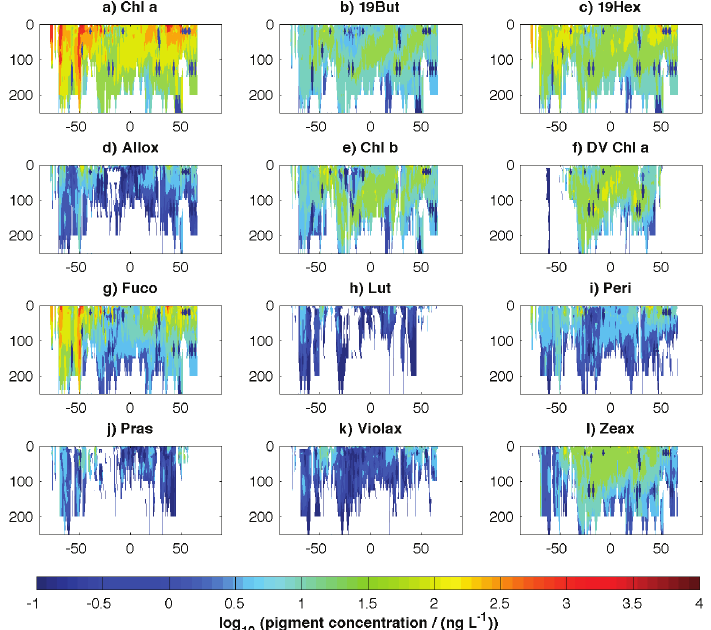
Figure 9. Zonal annual mean depth profiles of MAREDAT pigment concentrations (ngL − 1 ) as a function of latitude: (a) chlorophyll a (Chl a ), (b) 19’-butanoyloxyfucoxanthin (19But), (c) 19’-hexanoyloxyfucoxanthin (19Hex), (d) alloxanthin (Allox), (e) chlorophyll b (Chl b ), (f) di- vinyl chlorophyll a (DV Chl a ), (g) fucoxanthin (Fuco), (h) lutein (Lut), (i) peridinin (Peri), (j) prasinoxanthin (Pras), (k) violaxanthin (Violax) and (l) zeaxanthin (Zeax). The gridded data product (see Appendix A2: netCDF product) was used to compute the zonal and the annual mean (from 1 ◦ monthly mean